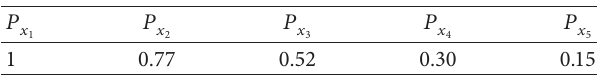
Table 10: Risk level hazard